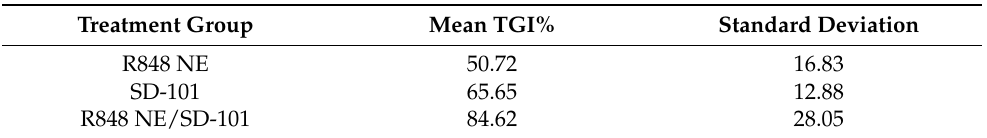
Table 1. Tumor growth inhibition (TGI%) at day 10 for R848 NE or SD-101 individually or in combination.